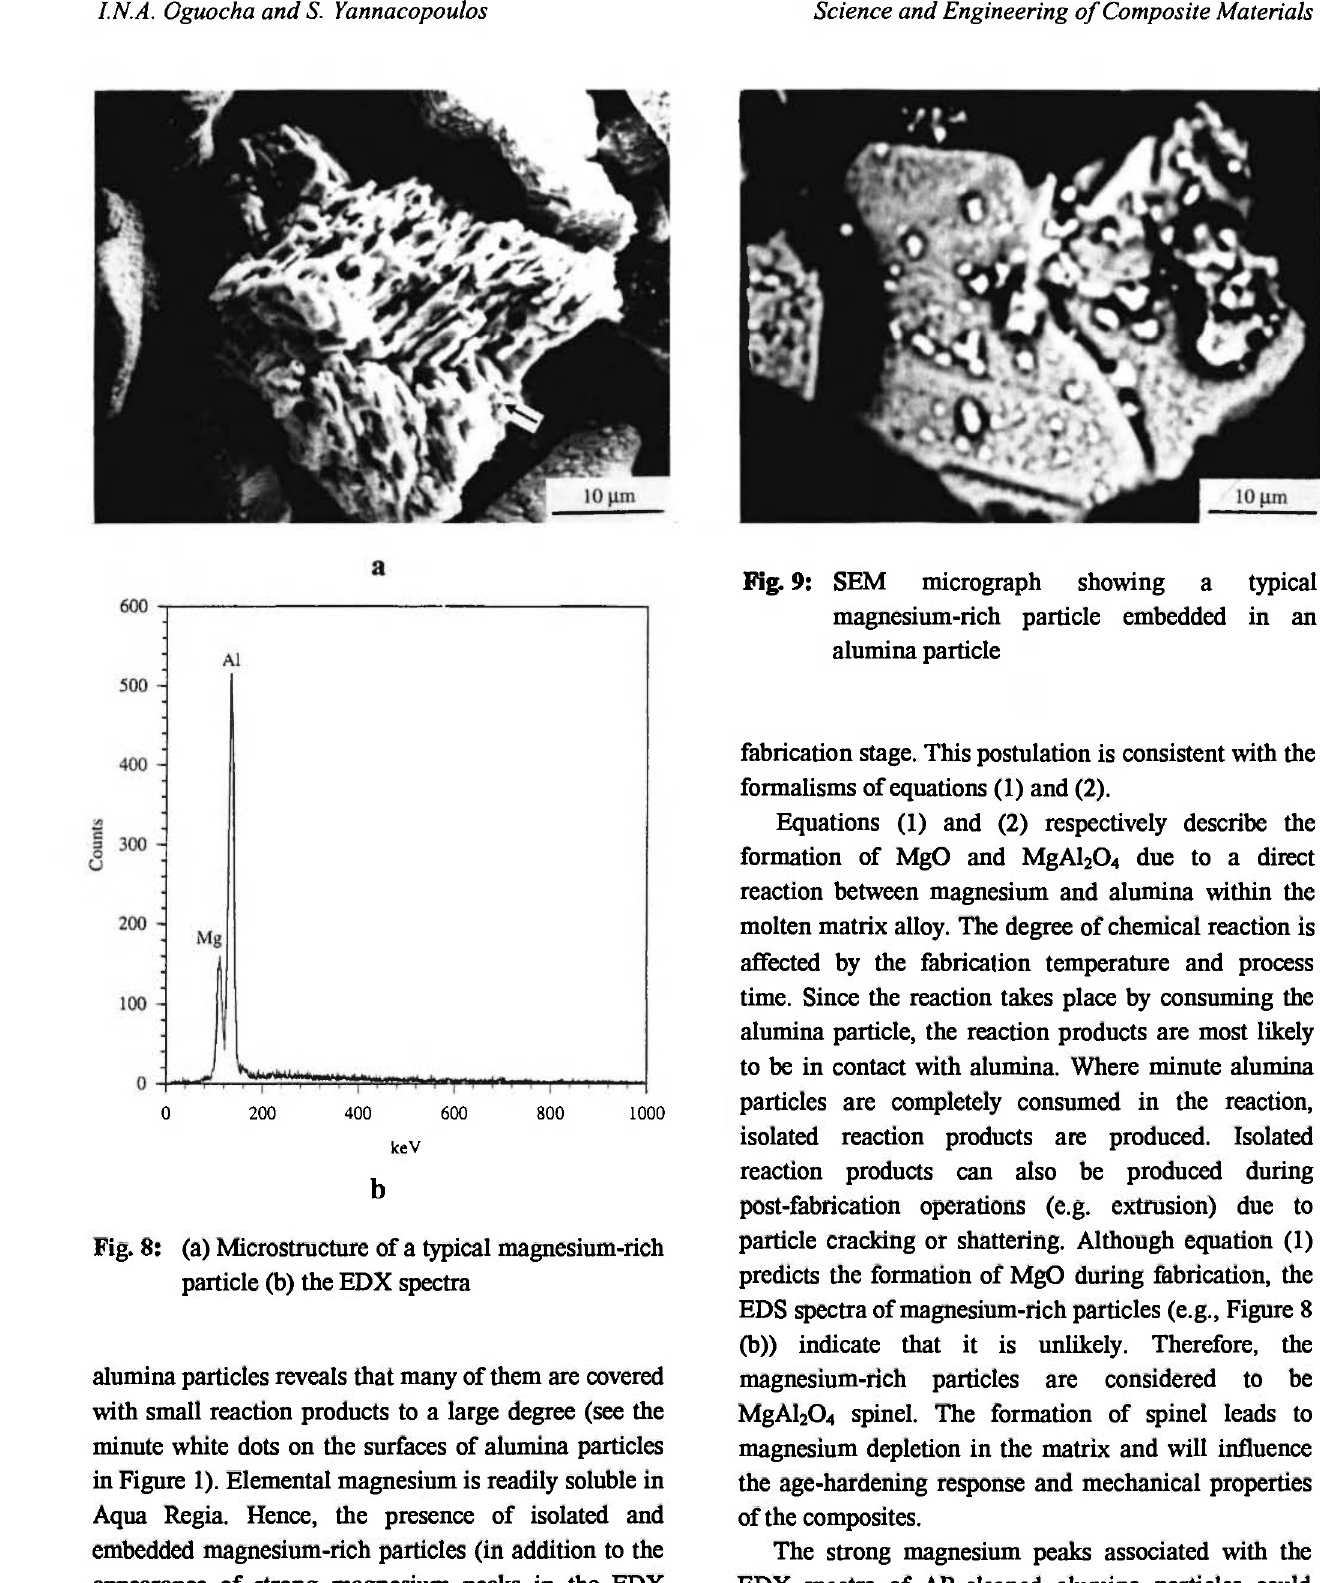
Fig. 9: SEM micrograph showing a typical magnesium-rich particle embedded in an alumina